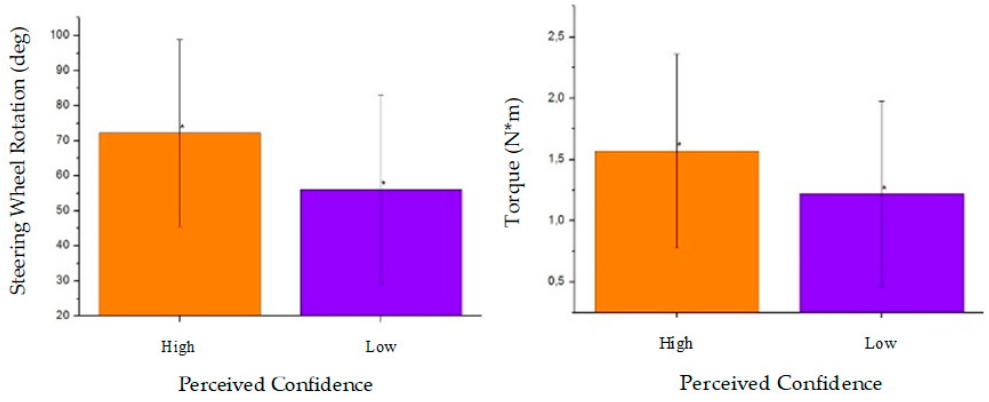
Figure 11. Oscillation and torque for “confidence” subgroups in the second maneuver.